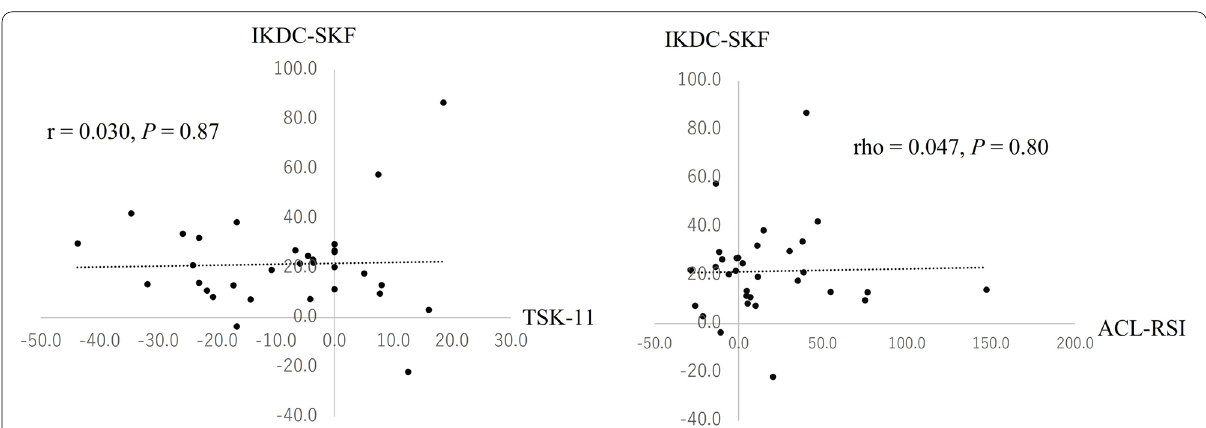
Fig. 3 Correlations of percentage change in the IKDC-SKF score from pre-ACLR to 6 months post-ACLR with that in the TSK-11 and ACL-RSI scores. ACLR, anterior cruciate ligament reconstruction; IKDC-SKF, International Knee Documentation Committee Subjective Knee Form; TSK-11, Tampa Scale for Kinesiophobia-11; ACL-RSI, Anterior Cruciate Ligament Return to Sport after Injury